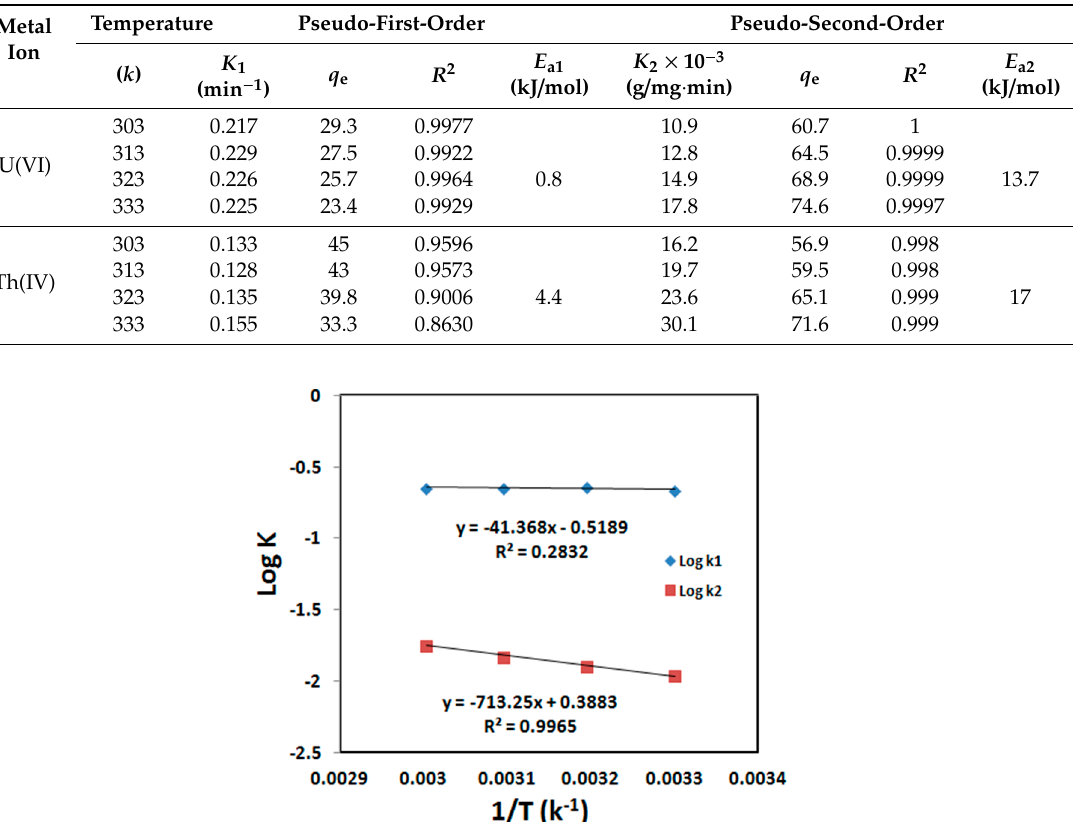
Figure 12. Plot of t / q t versus time for ( a ) U(VI) and ( b ) Th(IV) sorption onto HQ-bentonite. Conditions: